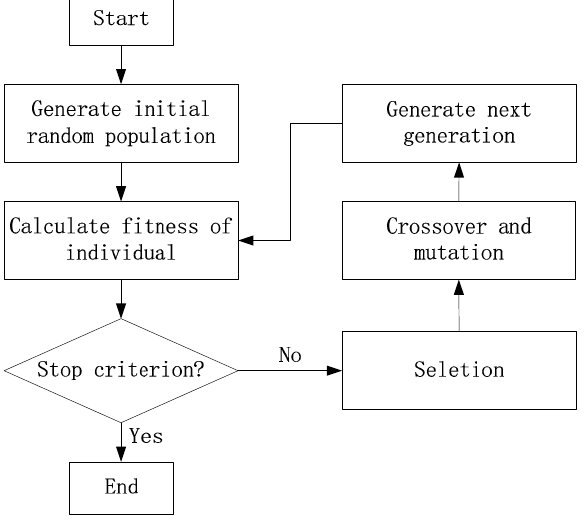
Figure 4. The flow chart of genetic algorithm.